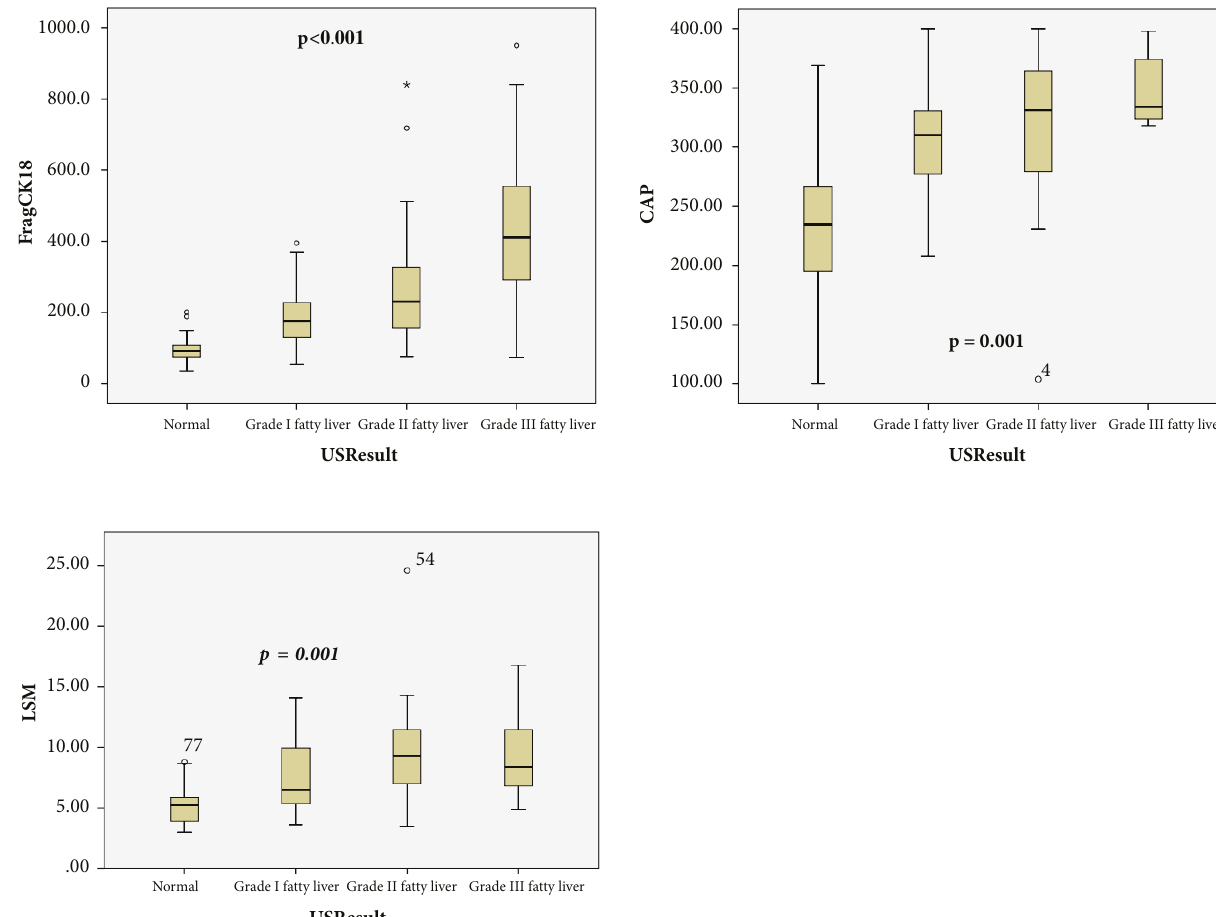
Figure 1: The distribution of CAP, LSM, and CK-18 according to steatosis grade assessed by US. Figure 1 showed significant difference in Fragmented CK-18, LSM, and CAP between nonliver steatosis patients and grades I, II, and III liver steatosis patients.